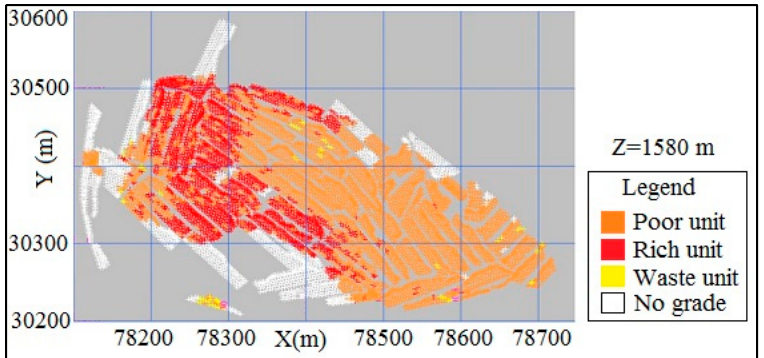
Figure 5. Elevation Z = 1585 m of blastholes classified by cutoff grade and threshold (horizontal section).